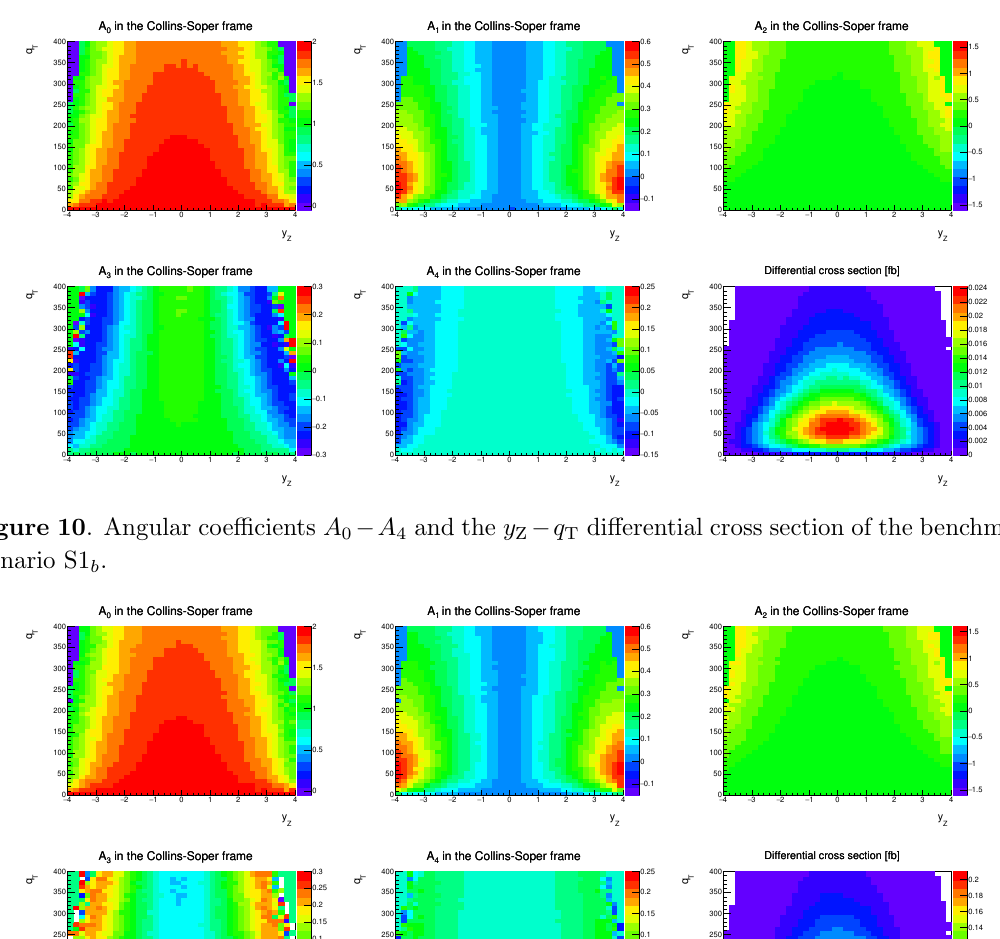
A 4 and the y Z q T di(cid:11)erential cross section of the benchmark (cid:0) (cid:0)